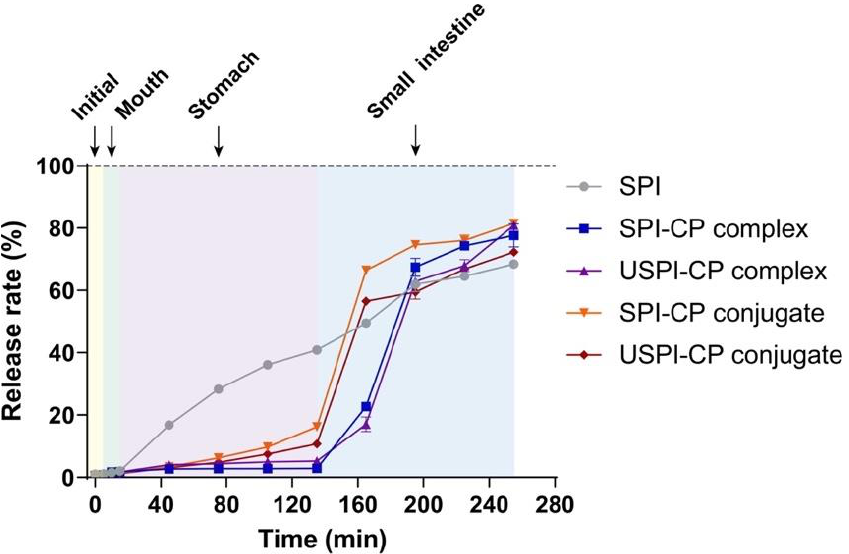
Figure 2. Release profiles of β -carotene from nanoemulsions stabilized by different emulsifiers during in vitro digestion. Samples: SPI, soy protein isolate; SPI–CP complex, electrostatic complex formed between soy protein isolate and citrus pectin; USPI–CP complex, electrostatic complex formed between soy protein isolate and citrus pectin with ultrasound treatment; SPI–CP conjugate, Maillard- type conjugate formed between soy protein isolate and citrus pectin; USPI–CP conjugate, Maillard- type conjugate formed between soy protein isolate and citrus pectin with ultrasound